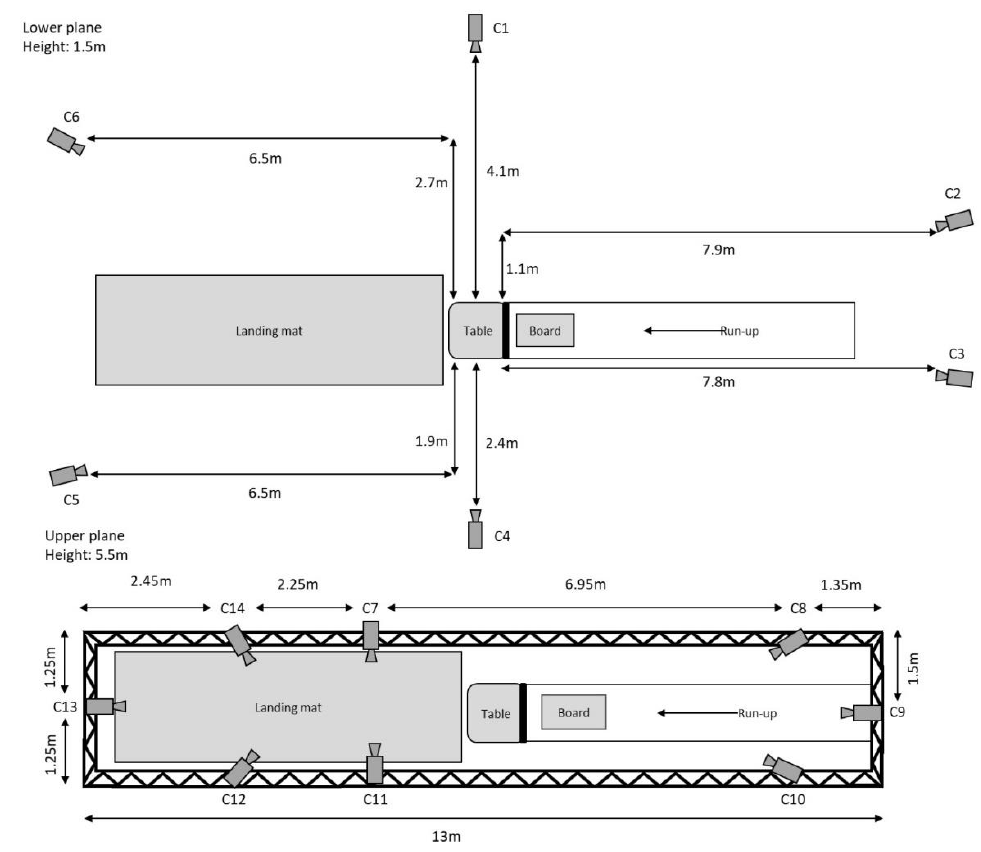
Figure 3. Placement of 3D cameras: positioning of the 14 Vicon Vantage Cameras (C1–C14) in an upper and lower plane for three-dimensional recording of vaults.